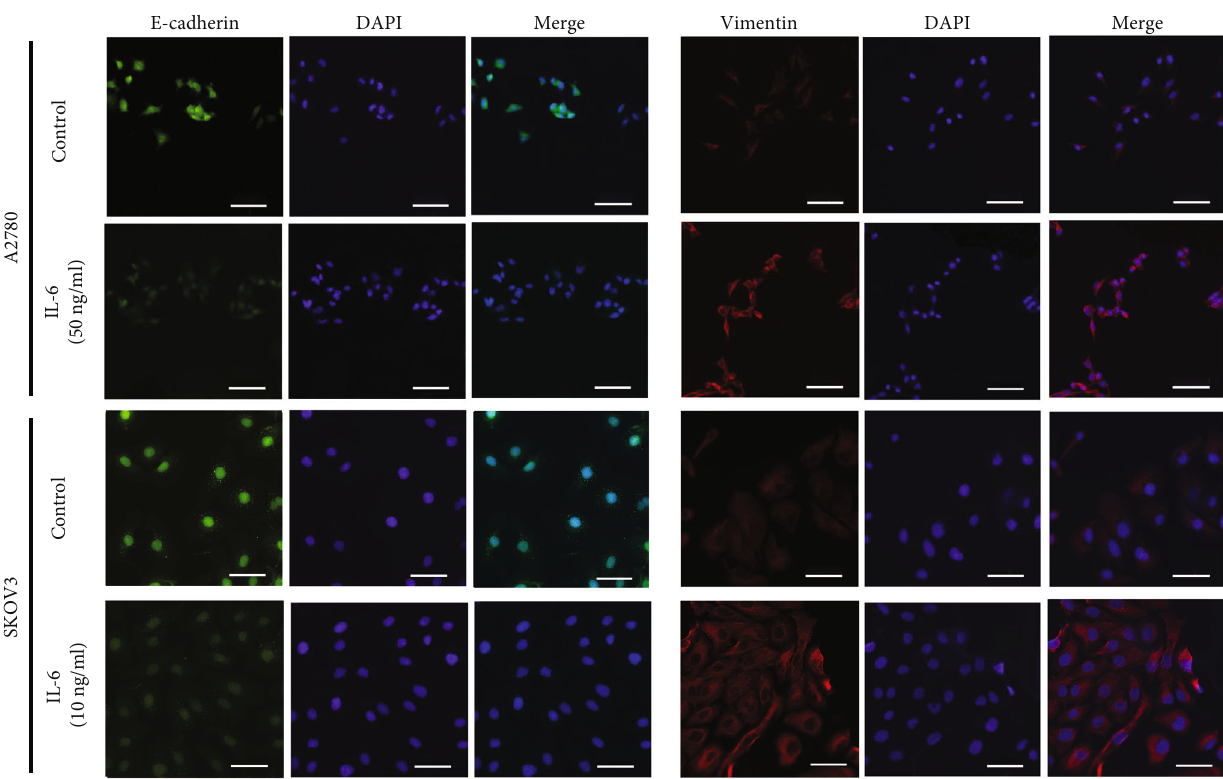
Figure 1: IL-6 promotes the EMT phenotype in EOC cell lines. A2780 cells were treated with exogenous IL-6 (50 ng/ml) for 24 hours, and SKOV3 cells were treated with exogenous IL-6 (10 ng/ml) for 48 hours under normoxic conditions. The expression and localization of E- cadherin and vimentin were then detected by immuno fl uorescence. The nuclei were stained with DAPI (blue) as an internal reference. E-cadherin and vimentin proteins were visualized by Alexa 488 fl uorescent labeling (green) and 549 fl uorescent labeling (red), respectively. Scale bars: 100 μ